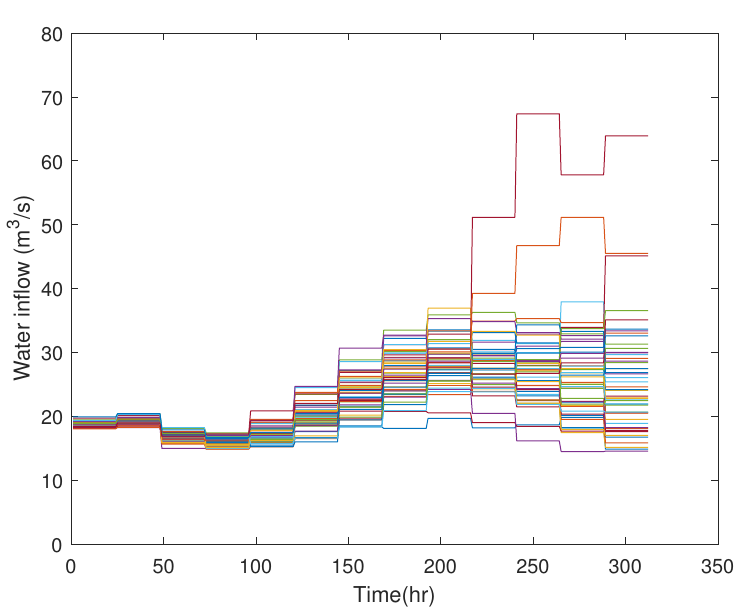
Figure 4. 50 ensembles of the water inflow prediction to lake Toke on 15 April 2020.